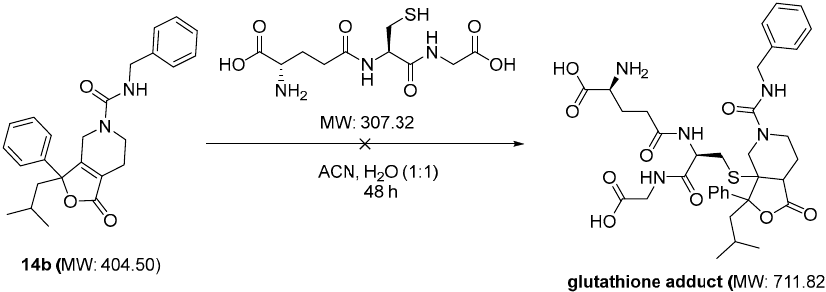
Scheme 4. Compound 14b is stable in the presence of excess of glutathione (18 mM).